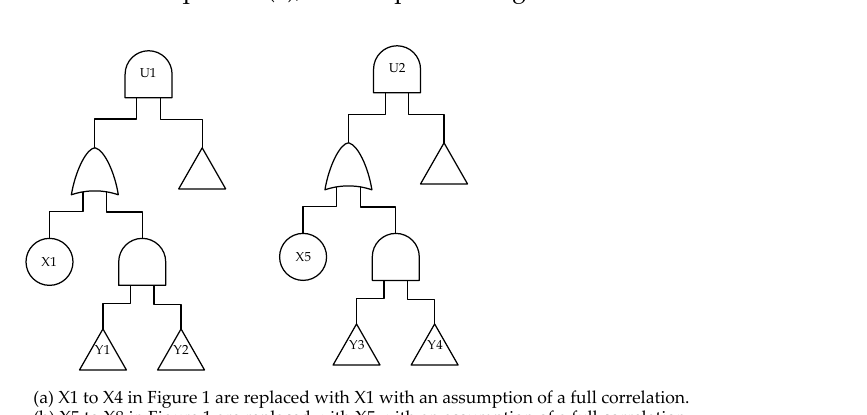
Figure 3. SUCDF fault tree simplified by the full correlation assumption (Model B).